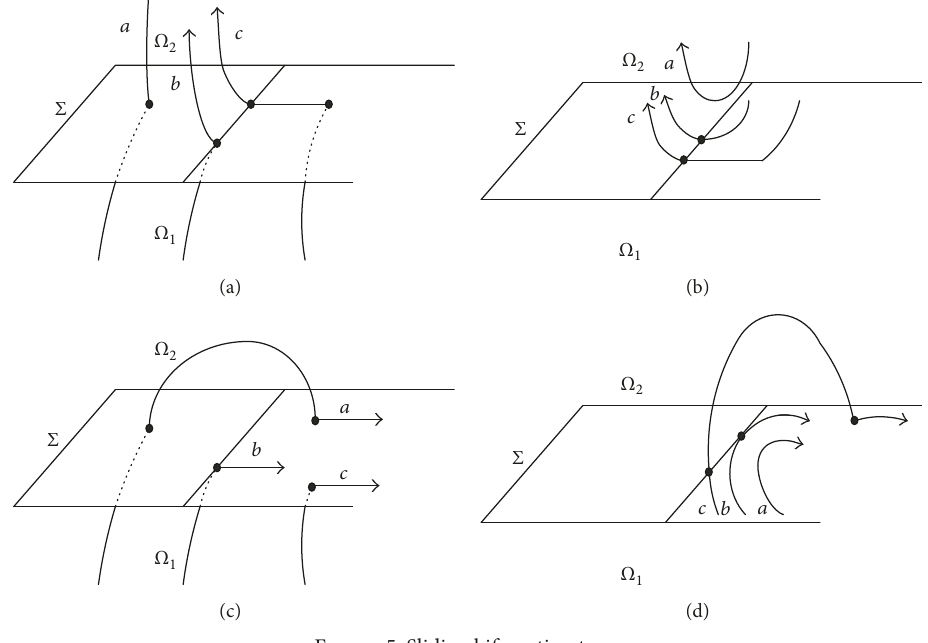
Figure 5: Sliding bifurcation